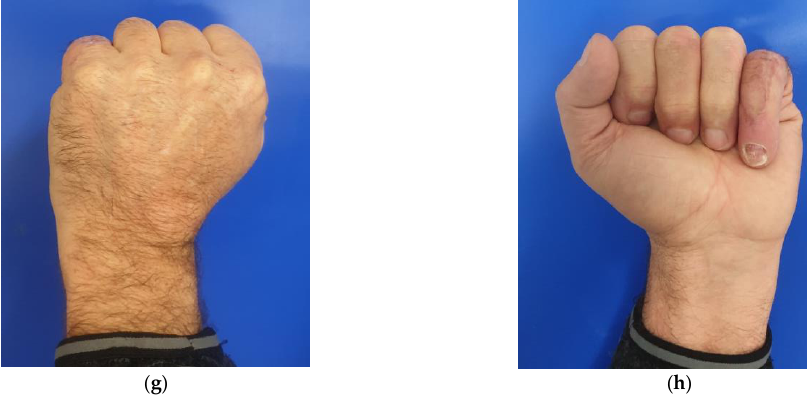
Figure 4. ( a ) 51 years old male patient with retracted skin, extensor tendon adhesions, and proximal interphalangeal joint post traumatic arthritis to the dorsum of the non-dominant left little finger; ( b , c ) tenoarthrolysis, joint replacement with a silastic implant, and reinforcement of the extensor tendon — the passive possible maximum flexion is shown; ( d ) harvesting of a retrograde free venous flap from the same forearm; ( e ) reconstruction of the skin of the dorsum of the finger — the arterialized vein is anastomosed end to end to the digital ulnar artery of the ring finger, dissected, and moved to the little finger; ( f – h ) result at 6 months with good finger extension and good flexion.